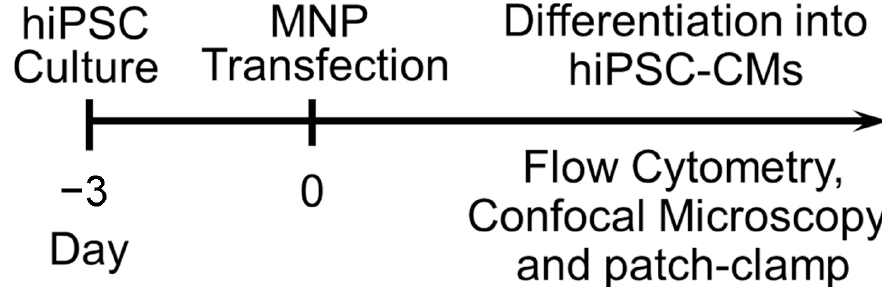
Figure 6. Schematic experimental protocol for iPSCs culture, biological and functional characterizations, and transfection. MNP: magnetic nanoparticle. We first tested the double fusion construct, and the confocal microscopic images of transfected cells are shown in Figure 7A. Flow cytometric analyses were used to directly quantify nanoparticle-mediated transfection in HEK 293 cells and hiPSCs (Figure 7B,C).